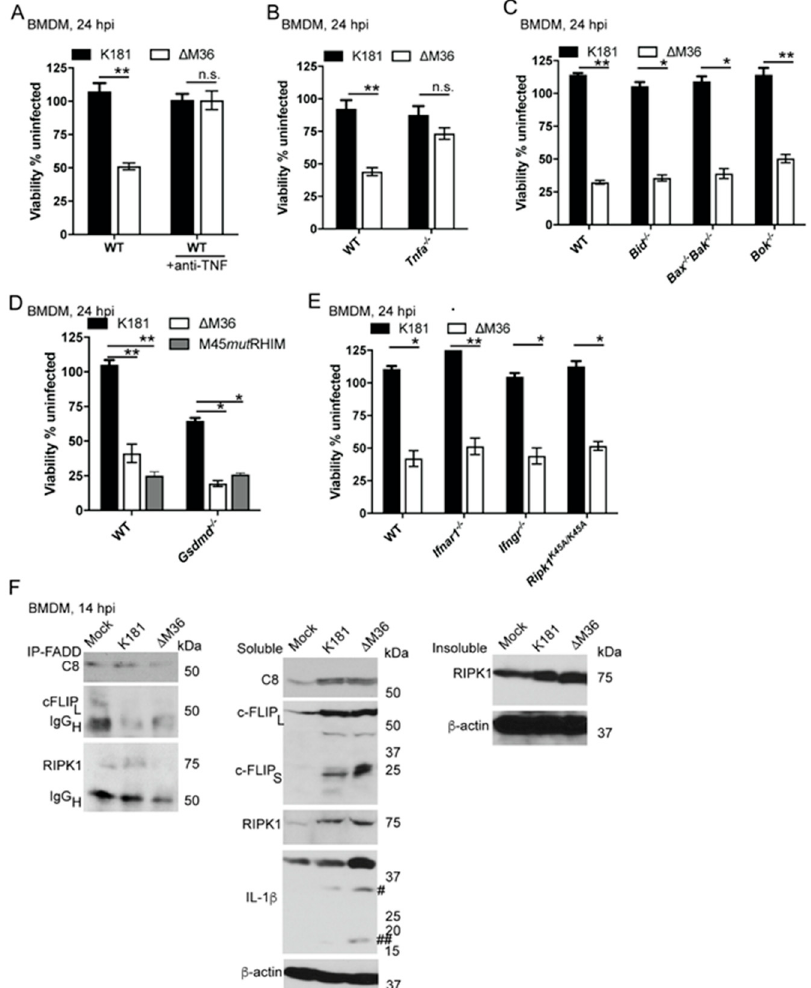
Figure 2. Tumor necrosis factor (TNF) drives ∆ M36-dependent apoptosis in BMDM. ( A ) Relative viability of WT BMDM infected with K181 or ∆ M36 (MOI = 10) for 24 h in the absence or presence of neutralizing anti-TNF (100 μ g/mL). anti-TNF was added in medium 1 hpi. ( B – E ) Relative viability of mutant BMDM when compared to WT cells at 24 hpi with indicated viruses. Viability graphs reflect data pooled from 3 to 5 independent experiments each containing 3 replicates. ( F ) IB showing the association of CASP8 (C8; 55 kDa), cellular FLICE inhibitory protein (cFLIP) (full length 55 kDa, indicated as cFLIP L ) and RIPK1 (75 kDa) with Fas-associated via death domain (FADD) when Triton-X solubilized cell lysates from K181- or ∆ M36-infected WT BMDM were subjected to immunoprecipitation at 14 hpi using anti-FADD antibody (left panel). Immunoglobulin (IgG) heavy chain (IgG H ; 50 kDa) was detected when membranes were incubated with either anti-cFLIP or RIPK1 antibodies. Middle panel indicates total levels of C8, cFLIP L , as well as cFLIP short (cFLIP S ; 25 kDa), RIPK1, and IL-1 β with both total (#; 31 kDa) and processed forms (##; 17 kDa) were detected in the soluble cell lysates. Right panel indicates RIPK1 level in the detergent-insoluble fraction. β -actin (38.5 kDa) serves as loading control. IB data are representative of 3 independent experiments. Lines above bars indicate the two groups compared for significance values using paired, parametric Student’s t-test where * is < 0.05, ** is < 0.001, and n.s. represents nonsignificant.